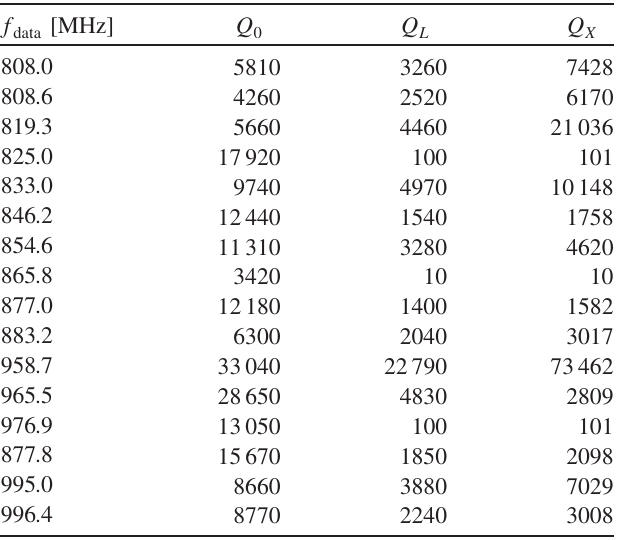
TABLE IV. Measured frequencies and Q values with stag- gered dampers.